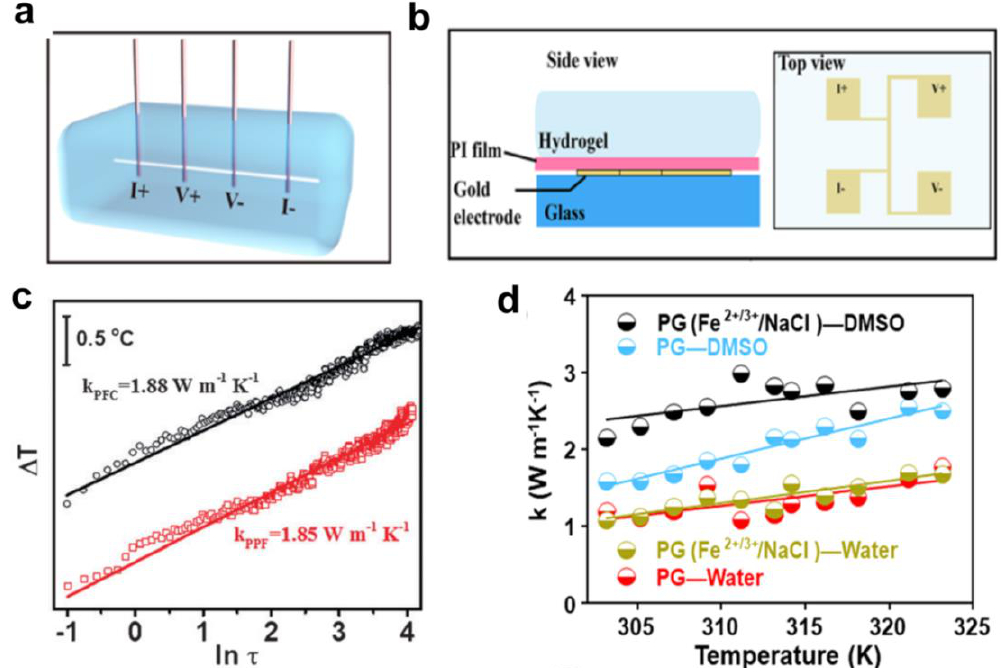
Figure 8. PAAm hydrogel and its experimental setup for thermal conductivity measurement. ( a ) Schematic of 3 ω method setup for thermal conductivity measurement of hydrogels. A platinum wire is deeply immersed in hydrogels and wired out with four copper probes for applied current and voltage measurements. The four brown rods are copper probes and the white line in hydrogel is the Pt wire. ( b ) Schematic of 3 ω method for thermal conductivity measurement of hydrogels at different water contents and temperatures. The four Au squares (2 mm in length) on a 1 mm thick glass substrate serve as both the heater and thermometer. (Reproduced with permission from [116]. Copyright 2017 MDPI). ( c ) Thermal conductivities of the thermogalvanic gels at room temperature. (Reproduced with permission from [56]. Copyright 2016 WILEY-VCH Verlag GmbH & Co. KGaA, Weinheim). ( d ) Variation of the thermal conductivity of the gel with temperature by changing different media. (Reproduced with permission from [117]. Copyright 2022 Elsevier Ltd.).